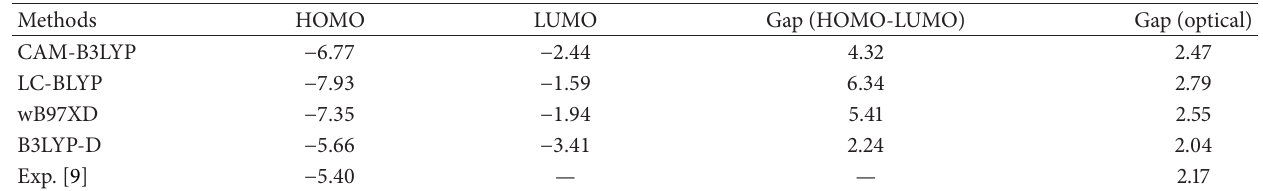
Table 1: Computed energies of frontier orbitals and the band gaps at different functionals for fully relaxed BCNDTS molecule. Energies are in eV.